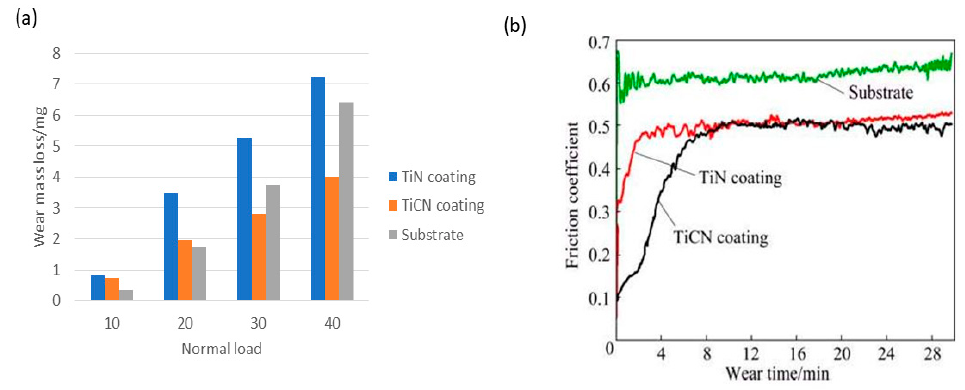
Figure 9. ( a ) Wear mass loss and ( b ) coefficients of friction vs. wear time curve for coatings and substrate [146].